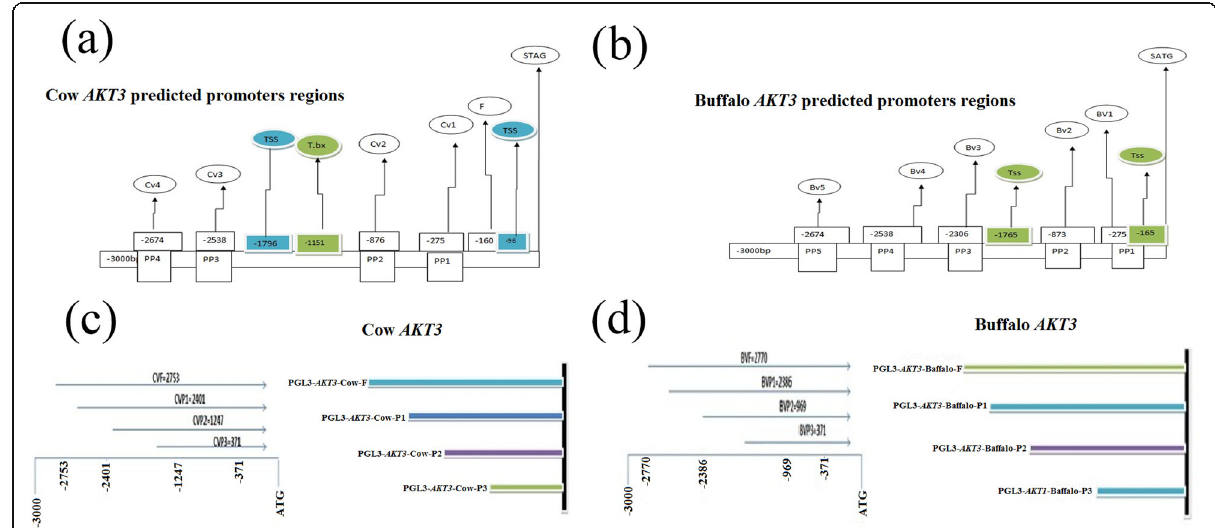
Fig. 4 a The AKT3 of cow predicted promoter position and distance from the starting ATG, with TSS and TATAA box. b The AKT3 of buffalo predicted promoter position and distance from the starting ATG, with TSS. c Describes the amplified promoter regions from starting ATG in cow sequence. d Describes the amplified promoter regions from starting ATG in buffalo sequence